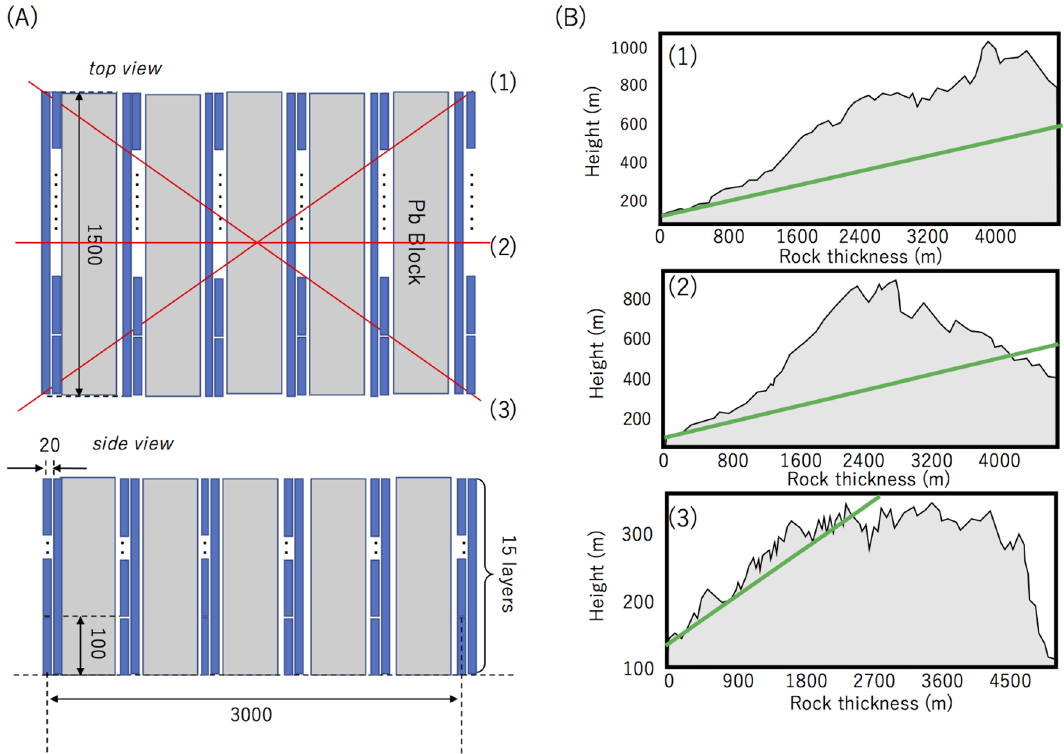
Figure 13. Experimental setup for measuring scattered upward-going muons. The top and side views of the geometrical configuration of the setup is shown in ( A ). The units are in mm. The blue rectangles and gray rectangles respectively indicate MSMs and lead blocks. Red lines indicate the azimuthal viewing angle of the setup. The cross-sectional views of the mountain located in the backward direction are shown in ( B ) for both edges (1 and 3) and the center (2) of the viewing angle. Green lines indicate the trajectories of muons arriving at a 100-mrad elevation